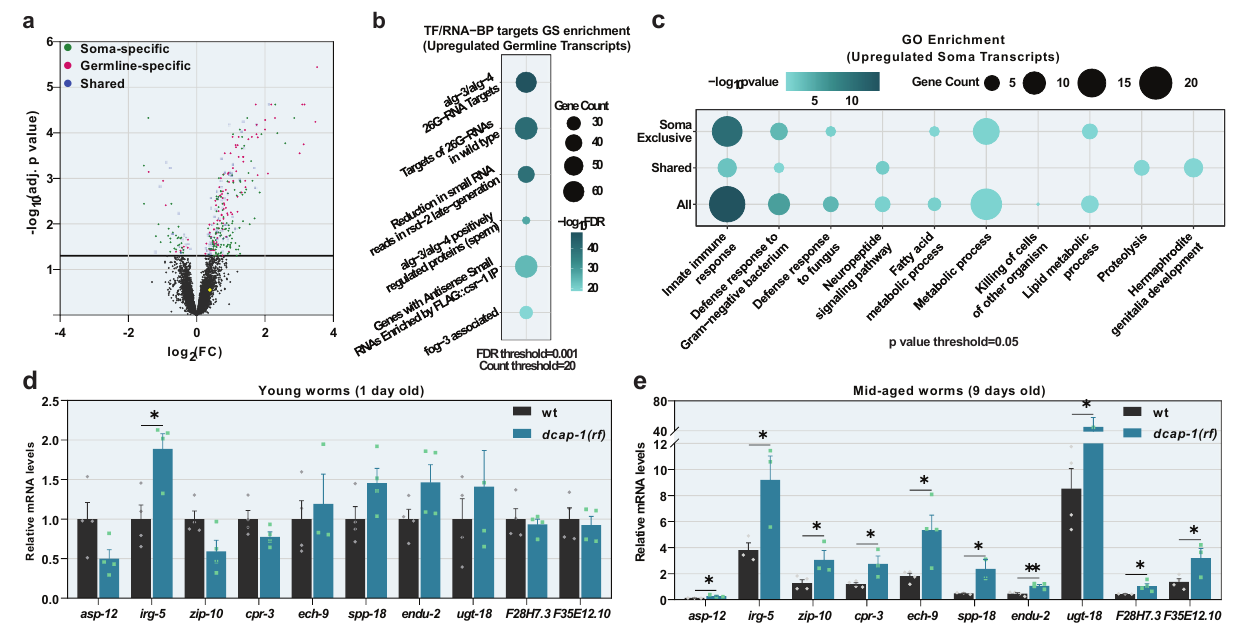
Figure 1. Reduced function of DCAP-1 alters gene expression. ( a ) Differentially expressed genes in 9 day-old dcap-1(rf) adult worms. Gray dots correspond to non-significant expression changes (adjusted p -value > 0.05). Green dots correspond to genes expressed in the soma, magenta in the germline and blue in both. Yellow dot corresponds to pqm-1 transcript. See also Table S3. ( b ) Gene set (GS) enrichment analysis for transcription factor (TF) or RNA binding protein (RNA-BP) targets in differentially expressed germline-specific transcripts. ( c ) Gene ontology (GO) enrichment analysis in upregulated somatic transcripts. Dot size corresponds to gene count in each category. Dot color corresponds to enrichment significance. See also Table S5. ( d , e ) Relative mRNA levels of immunity related genes in 1 day and 9 day-old dcap-1(rf) animals, determined by qRT-PCR. Symbols represent individual values. Bars represent mean ± SEM. All values are expressed relative to 1 day-old wt animals. * p ≤ 0.05, ** p ≤ 0.01. Unpaired t -tests.